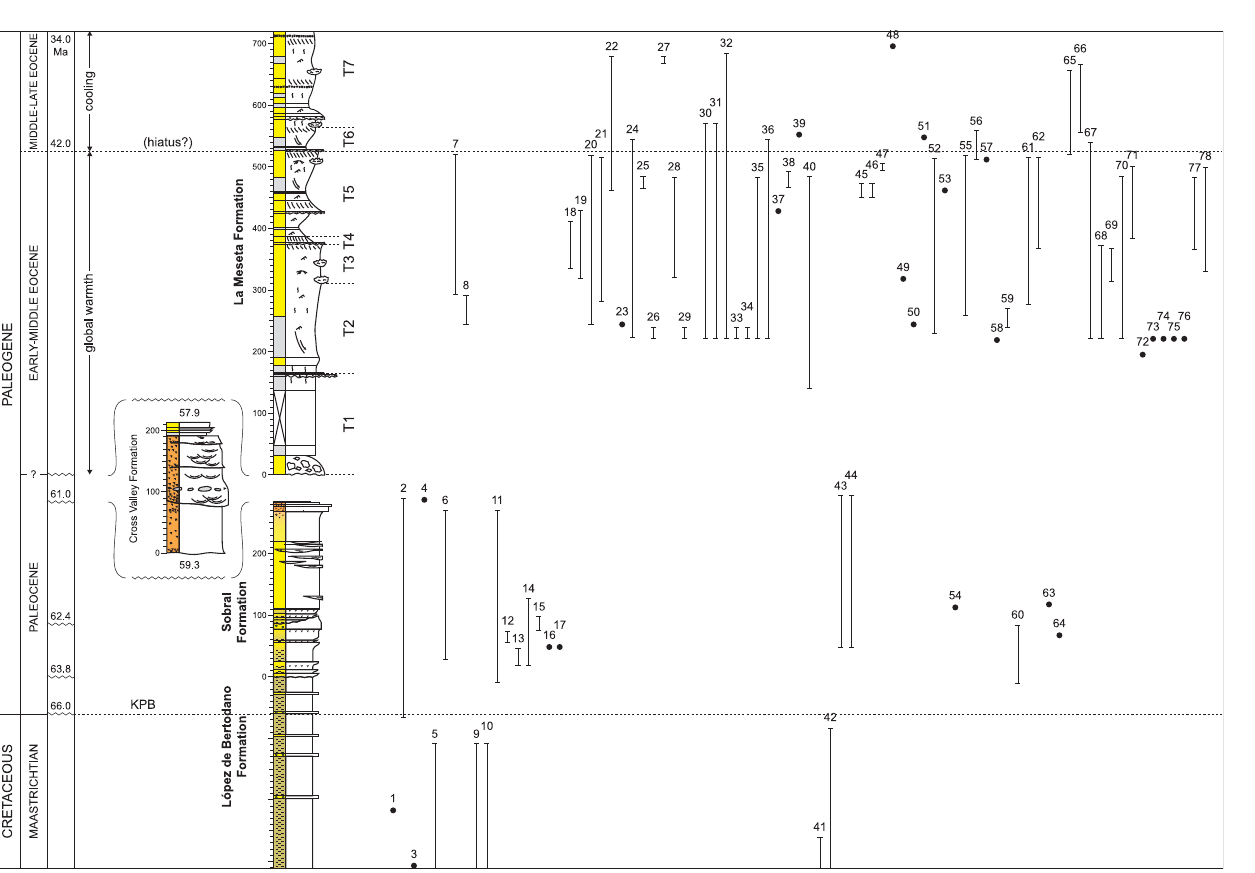
(Table 1; S2 Appendix). In comparison, there are only 37 genera of bivalves from the same unit, although it should be pointed out that some of these taxa are still extremely abundant, such as the species of Cucullaea and Retrotapes that are so